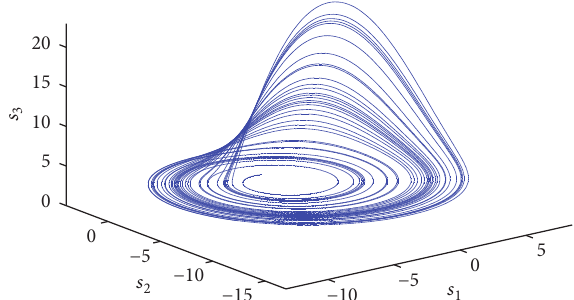
Figure 3: The chaotic behavior of R¨ossler system.